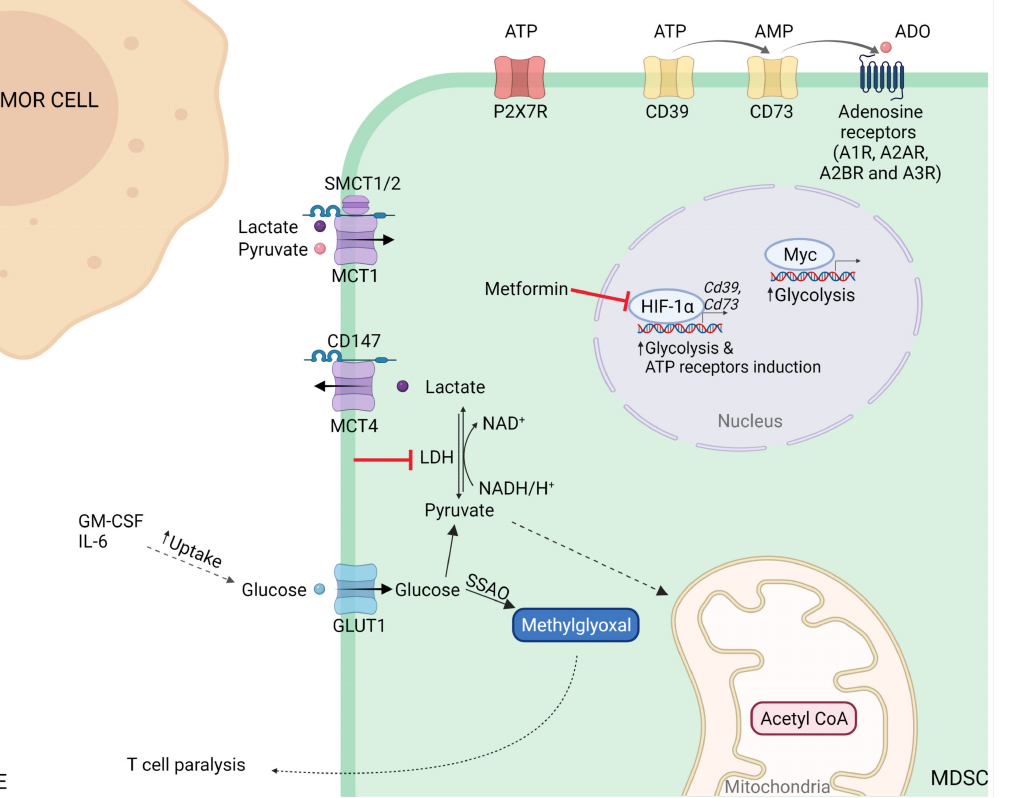
Figure 1. The effect of tumor microenvironment on the glucose metabolism of MDSCs. Cytokines (i.e., GM-CSF, IL-6) secreted by cancer cells boost both glucose uptake and MDSC glycolysis, leading to an increased production of lactate, that is transported across plasma membrane through monocarboxylate transporters (MCTs). Additionally, hypoxia regulates the glycolytic pathway of MDSC by hypoxia-inducible factor (HIF-)1 α , that enhance the immunosuppressive features and the CD39/CD73 ecto-enzymes spread on MDSC membranes. Furthermore, the TME is rich in extracellular adenosine triphosphate (ATP) and its metabolites (ADP, adenosine diphosphate; ADO, adenosine), which can either stimulate P2X7R receptor or be degraded to ADO by the consecutive action of CD39 and CD73. NAD or NADH, nicotinamide adenine dinucleotide; SSAO, semicarbazide-sensitive amine oxidase; GLUT1, glucose transporter 1; SMCT, sodium-coupled monocarboxylate transporter; LDH, lactate